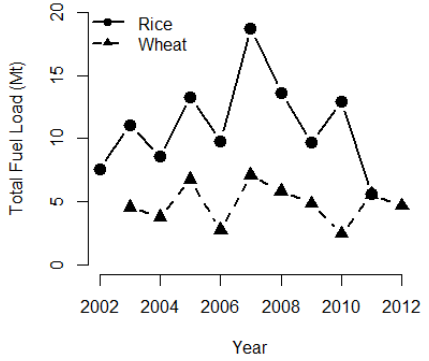
Figure 6. Total fuel loads during rice and wheat harvesting periods in